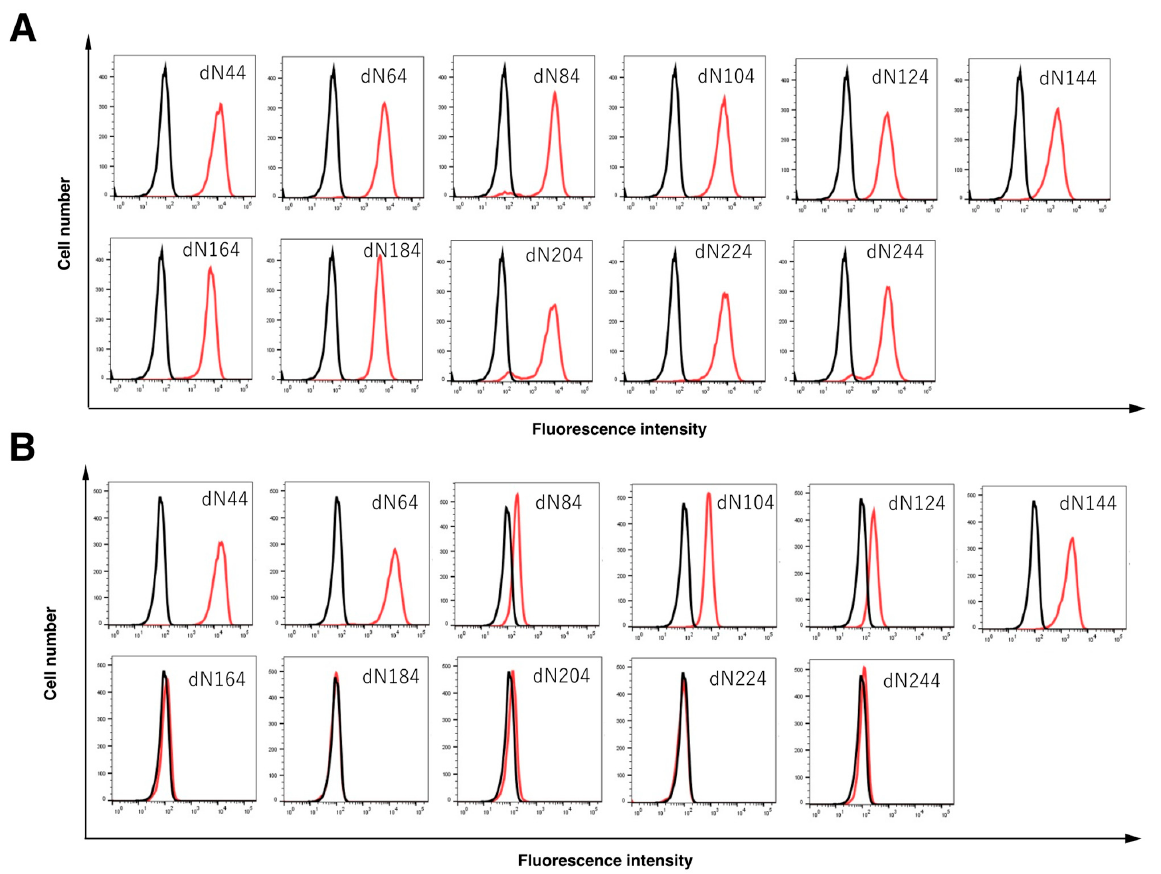
Figure 4. Epitope mapping of recEpMab-37 using deletion mutants of EpCAM. CHO-K1 expressed EpCAM deletion mutants were analyzed using flow cytometry. The EpCAM mutants-transfected cells were incubated with NZ-1 (anti-PA tag; red line, ( A )), recEpMab-37 (anti-EpCAM mAb; red line, ( B )), or buffer control (black line, ( A , B )) for 30 min at 4 °C, followed by secondary antibodies.